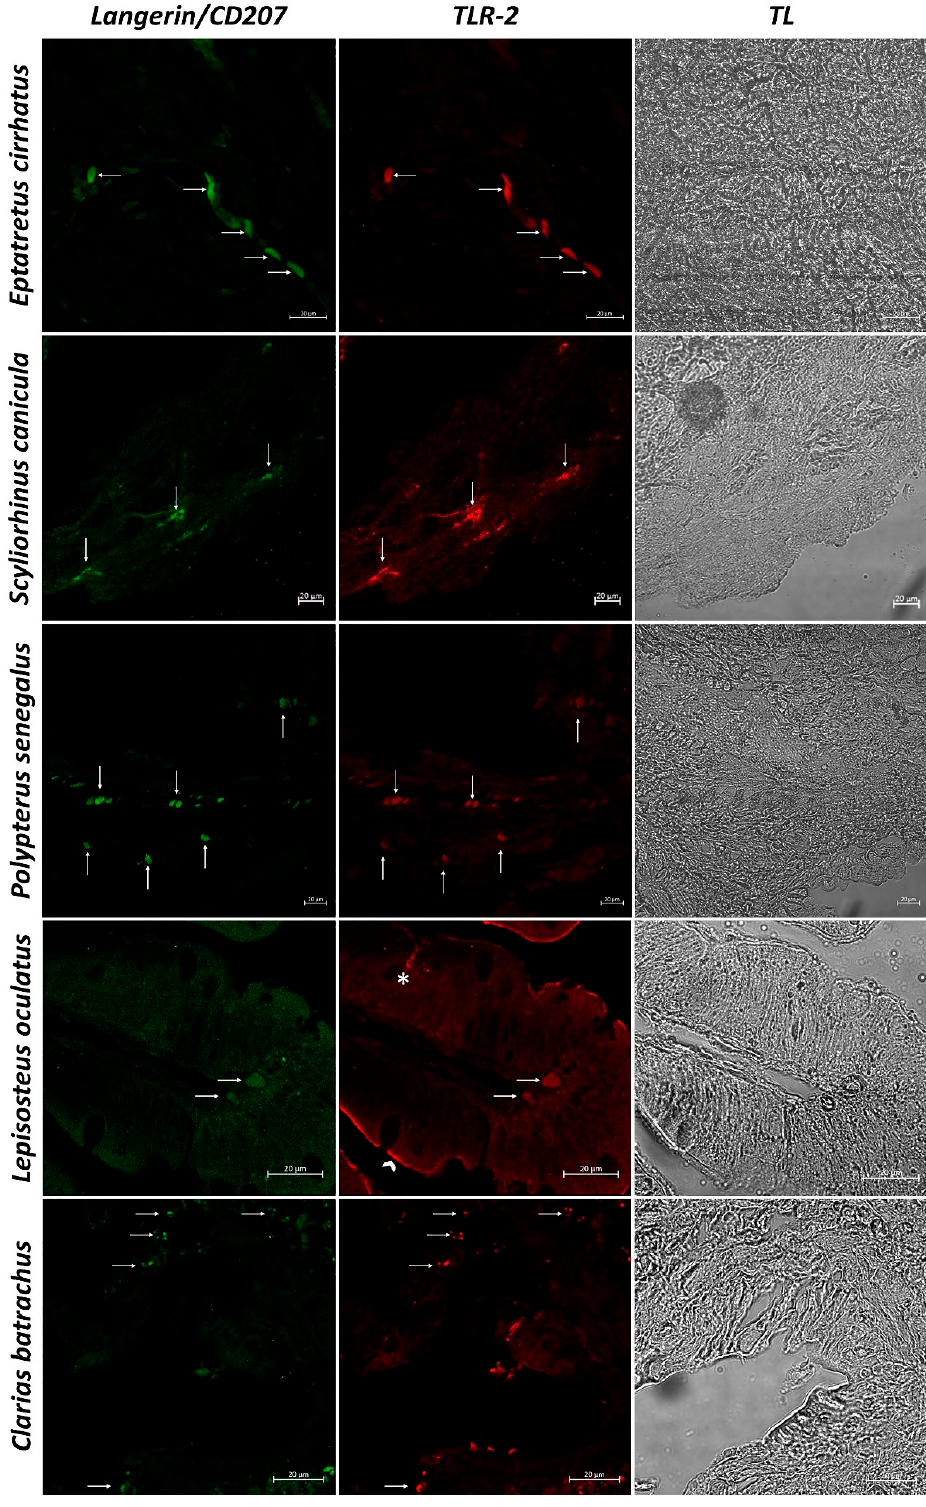
Commented [M20]: Please add the explanation of scale bar. The same as below figures. Commented [AA21R20]: Added